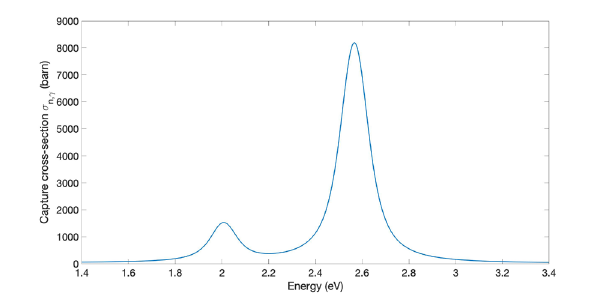
Figure 1. Capture cross-section for 155 Gd from time-of-flight experiment